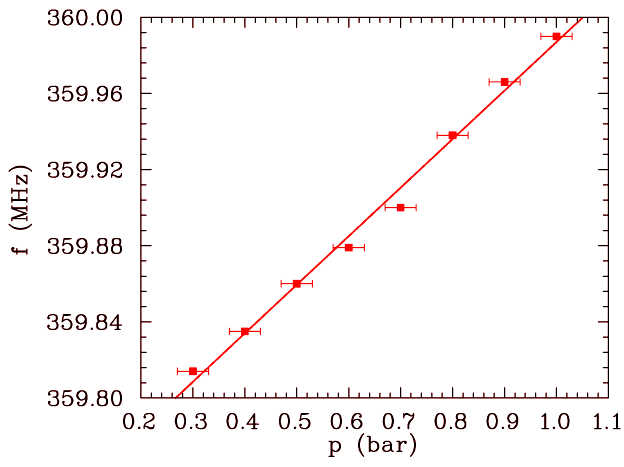
FIG. 37. (Color) Measured x-ray dose along the CH structure (top) and position of the x-ray TLD detectors inside the girders.